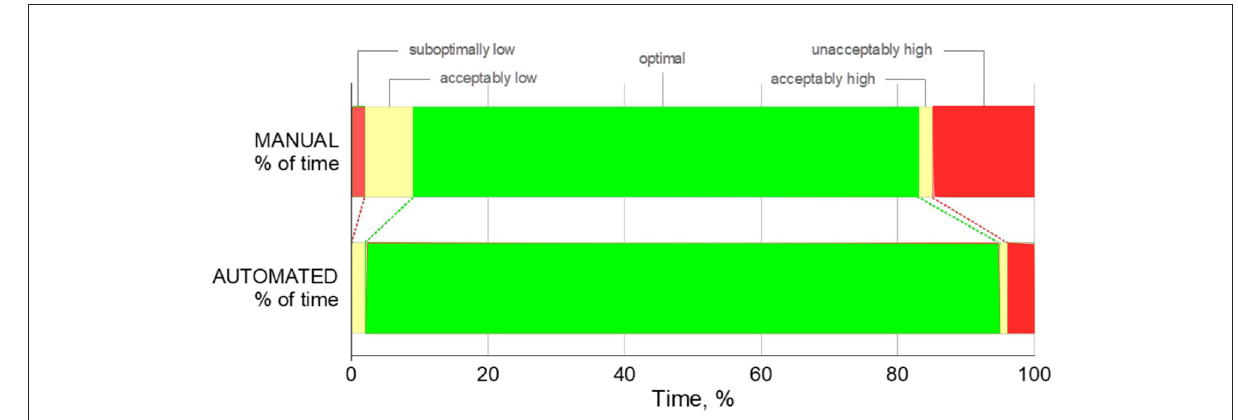
FIGURE4 Percentage of time spent in unacceptably high/low, acceptably high/low, optimal SpO 2 zones. For illustrative purposes, width of each bar represents the mean percentage of time